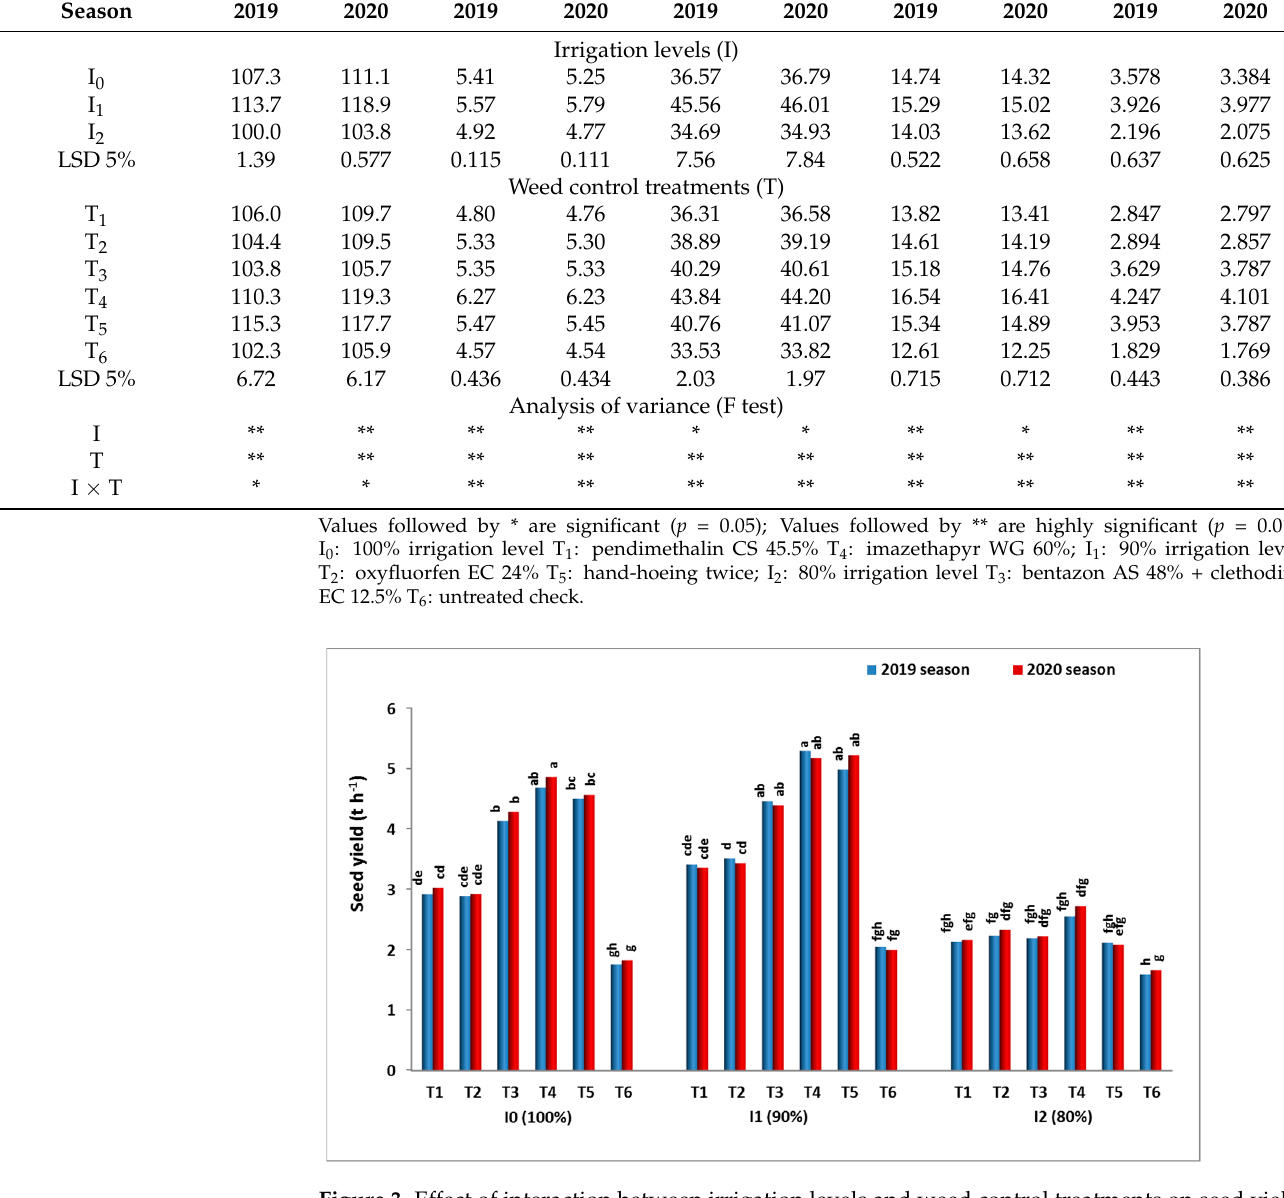
9.88 µg mL − 1 ) and Chl b (3.73 and 3.80 µg mL − 1 ) in the two seasons, respectively, followed